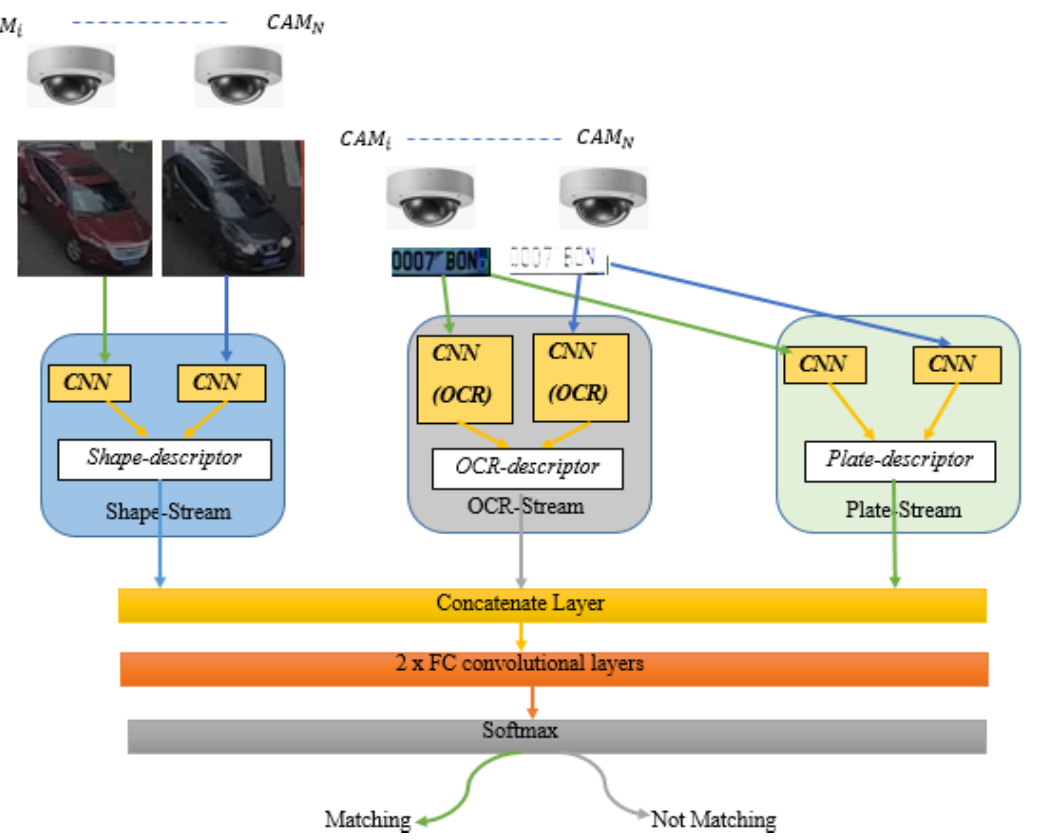
Figure 1. Overview of the proposed TSDCNN architecture and procedural flow.